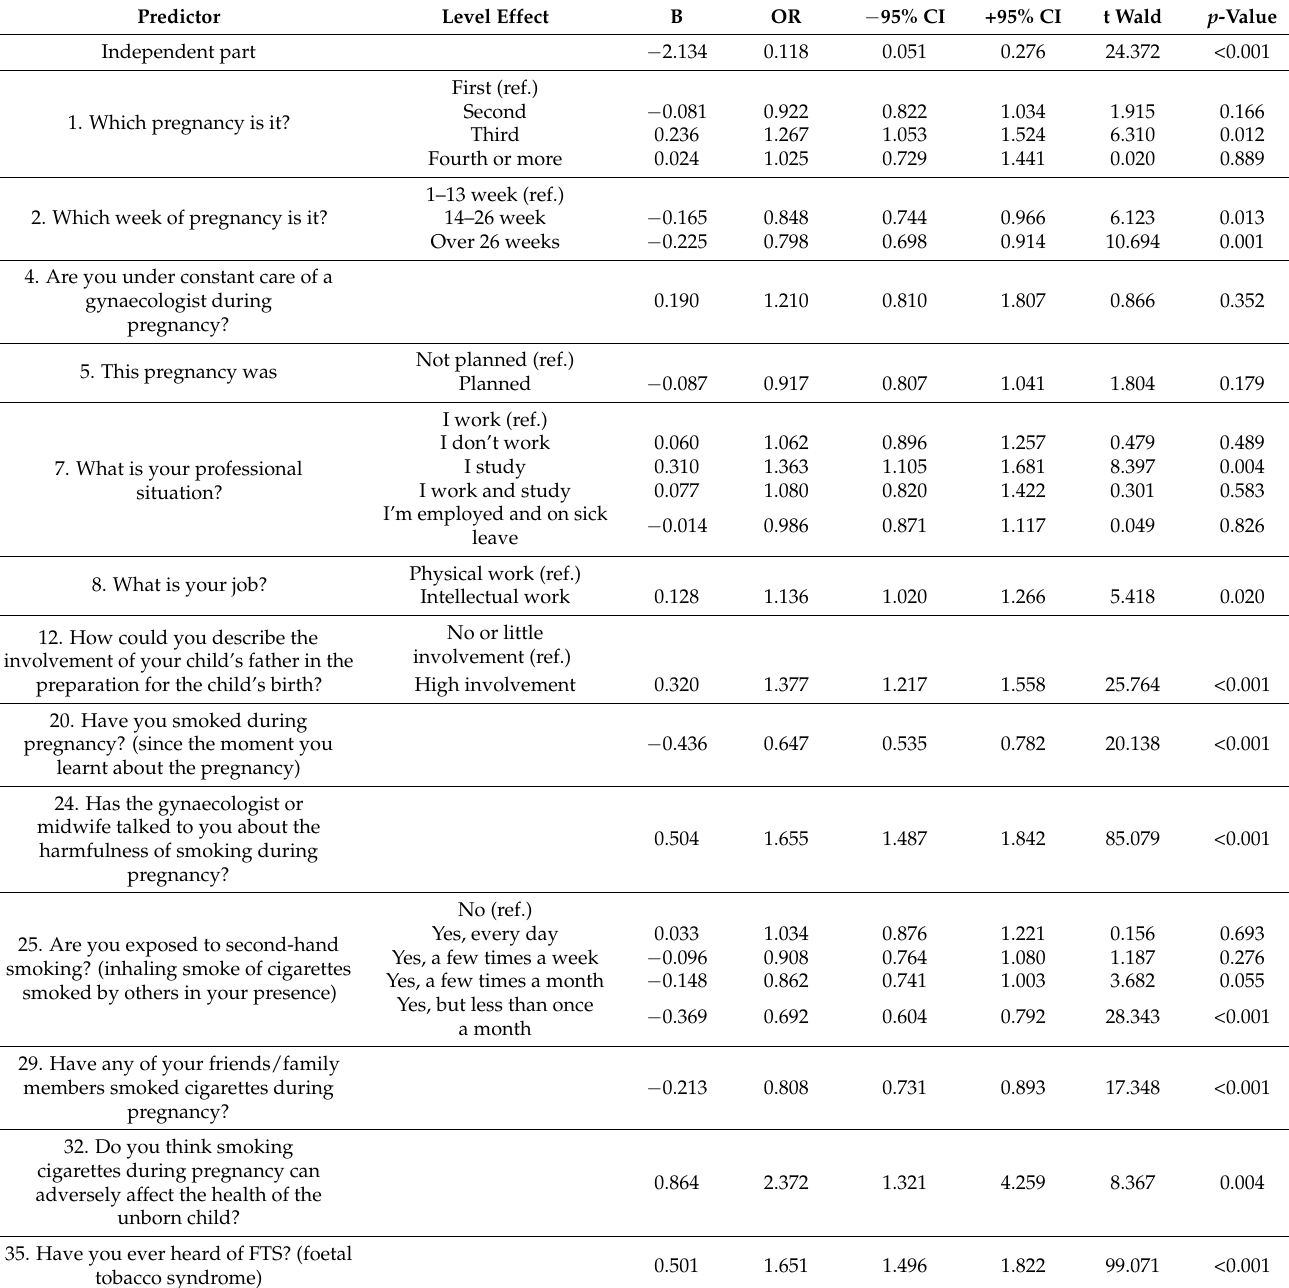
Table 2. Model of logistic regression for the “yes” variable with regard to the question “Would you draw the attention of a pregnant woman who was a stranger to the fact that smoking is harmful?” Predictor Level Effect B OR − 95% CI +95% CI t Wald p -Value Independent part −